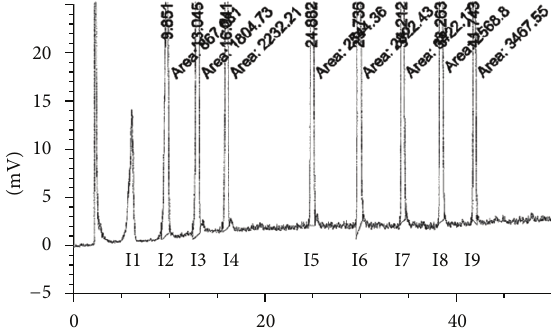
Figure 3: Chromatogram of the assessed known impurities,